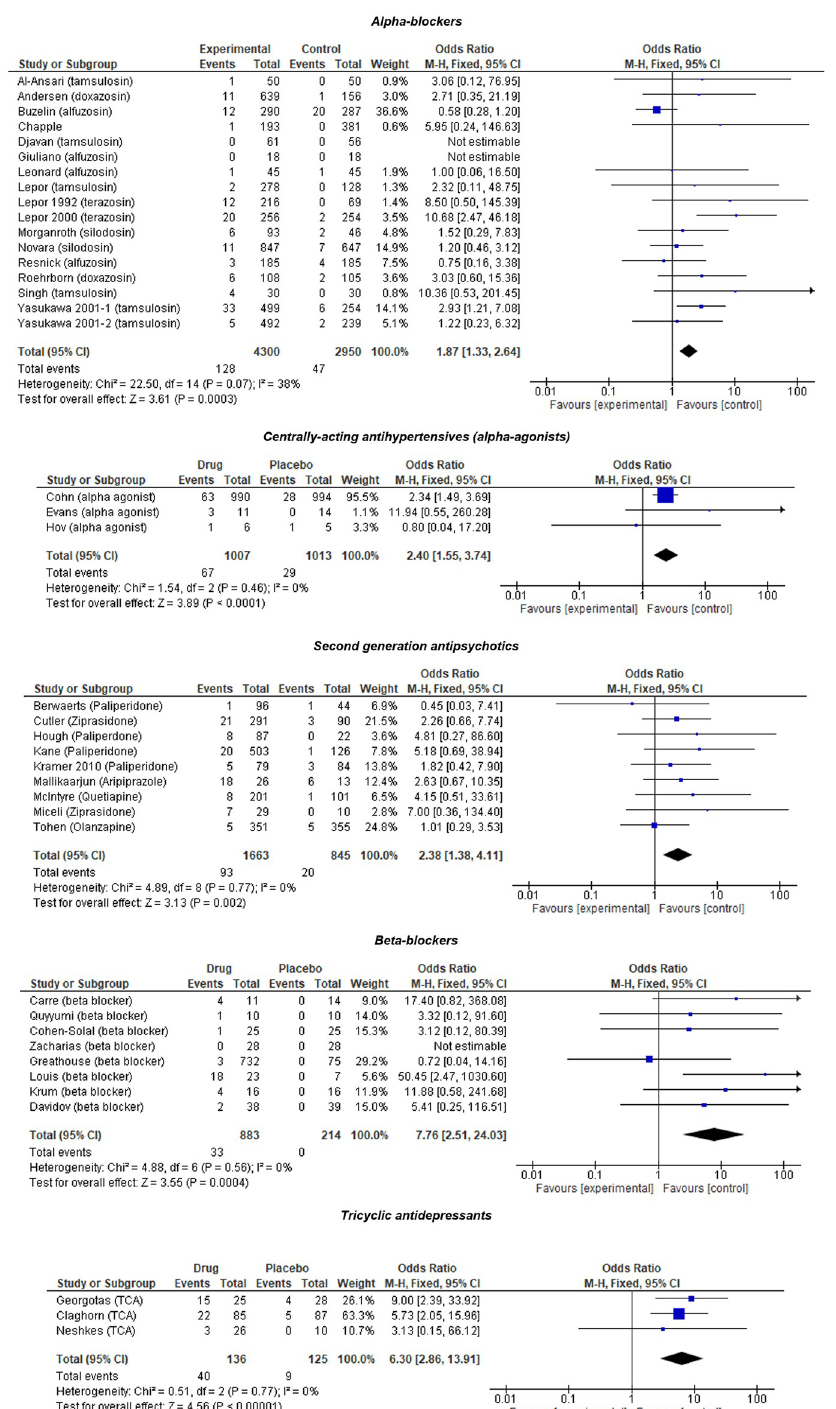
Fig 3. Meta-analysis results for sympathetic inhibitors vs placebo. TCA, tricyclic antidepressant.